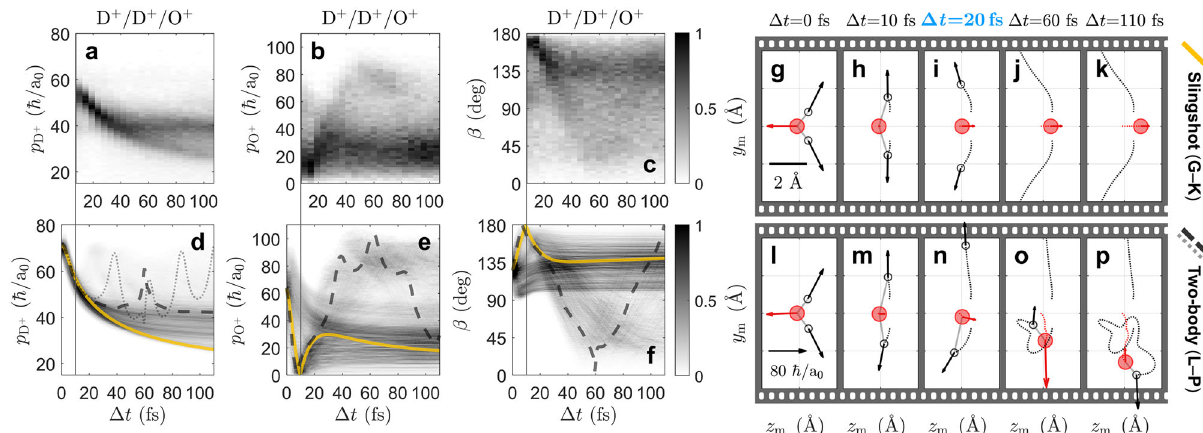
Fig. 3 Filming nuclear motion in D 2 O 2 + . a – c Measured distributions of deuteron momentum ( p D þ ), oxygen-ion momentum ( p O þ ), and momentum-frame bend-angle ( β ) plotted as a function of interpulse delay ( Δ t ), detected in the triply charged three-body dissociation channel (D + /D + /O + ). d – f Theoretical distributions of p D þ , p O þ , and β as a function of Δ t . g – k A series of fi lm-strip plots for the class of trajectory labeled “ slingshot ” . These plots display both the position of the atoms (red solid circles for oxygen and black open circles for hydrogen) and their corresponding asymptotic momenta following formation of the trication. l – p Another series of fi lm-strip plots for the class of trajectory labeled “ two-body ” . The slingshot and two-body trajectories are highlighted in ( d – f ) where a solid yellow line represents the slingshot trajectory, and the dashed (and dotted) black lines represent the two-body